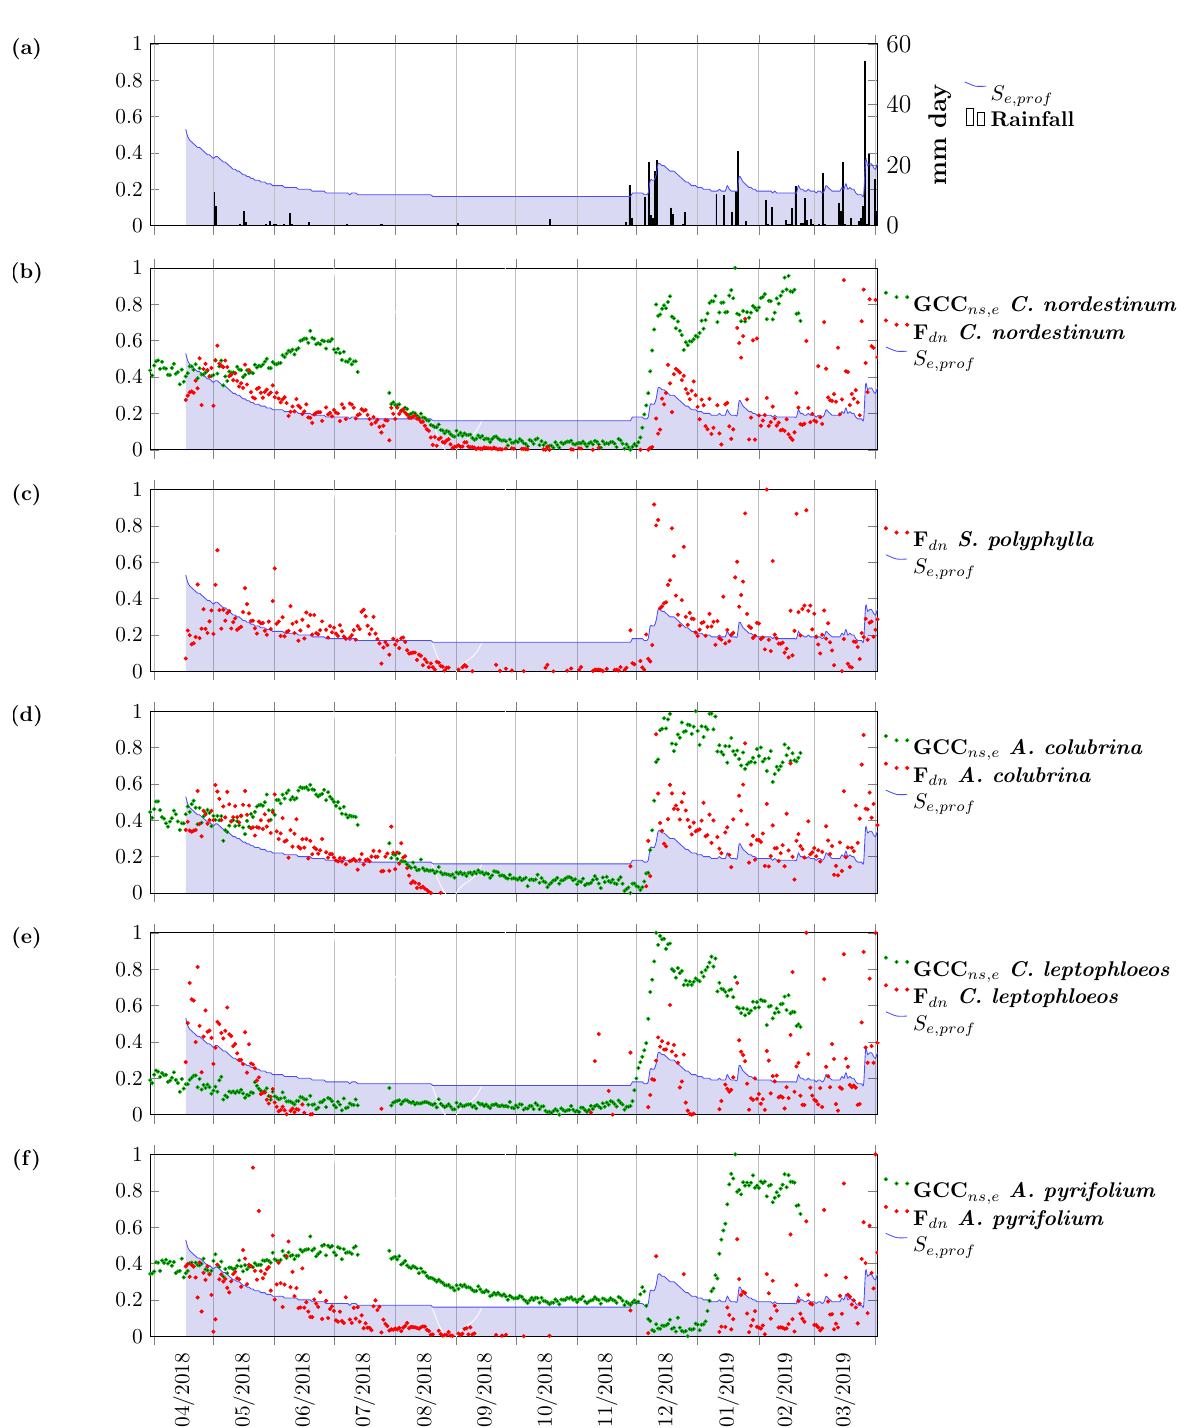
Figure 6. ( a ) Rainfall (mm day − 1 ) and soil water profile relative saturation ( S e , prof , dimensionless); and normalized near surface species GCC (GCC ns , e , dimensionless) , and species averaged sap flow density (F dn , dimensionless), together with S e , prof for ( b ) C. nordestinum and S e , prof ; ( c ) S. polyphylla ; ( d ) A. colubrina ; ( e ) C. leptophloeos ; ( f ) A. pyrifolium